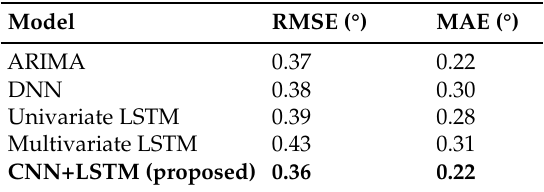
Table 9. RMSEs and MAEs of each model in “JingHai-III” test set-3.